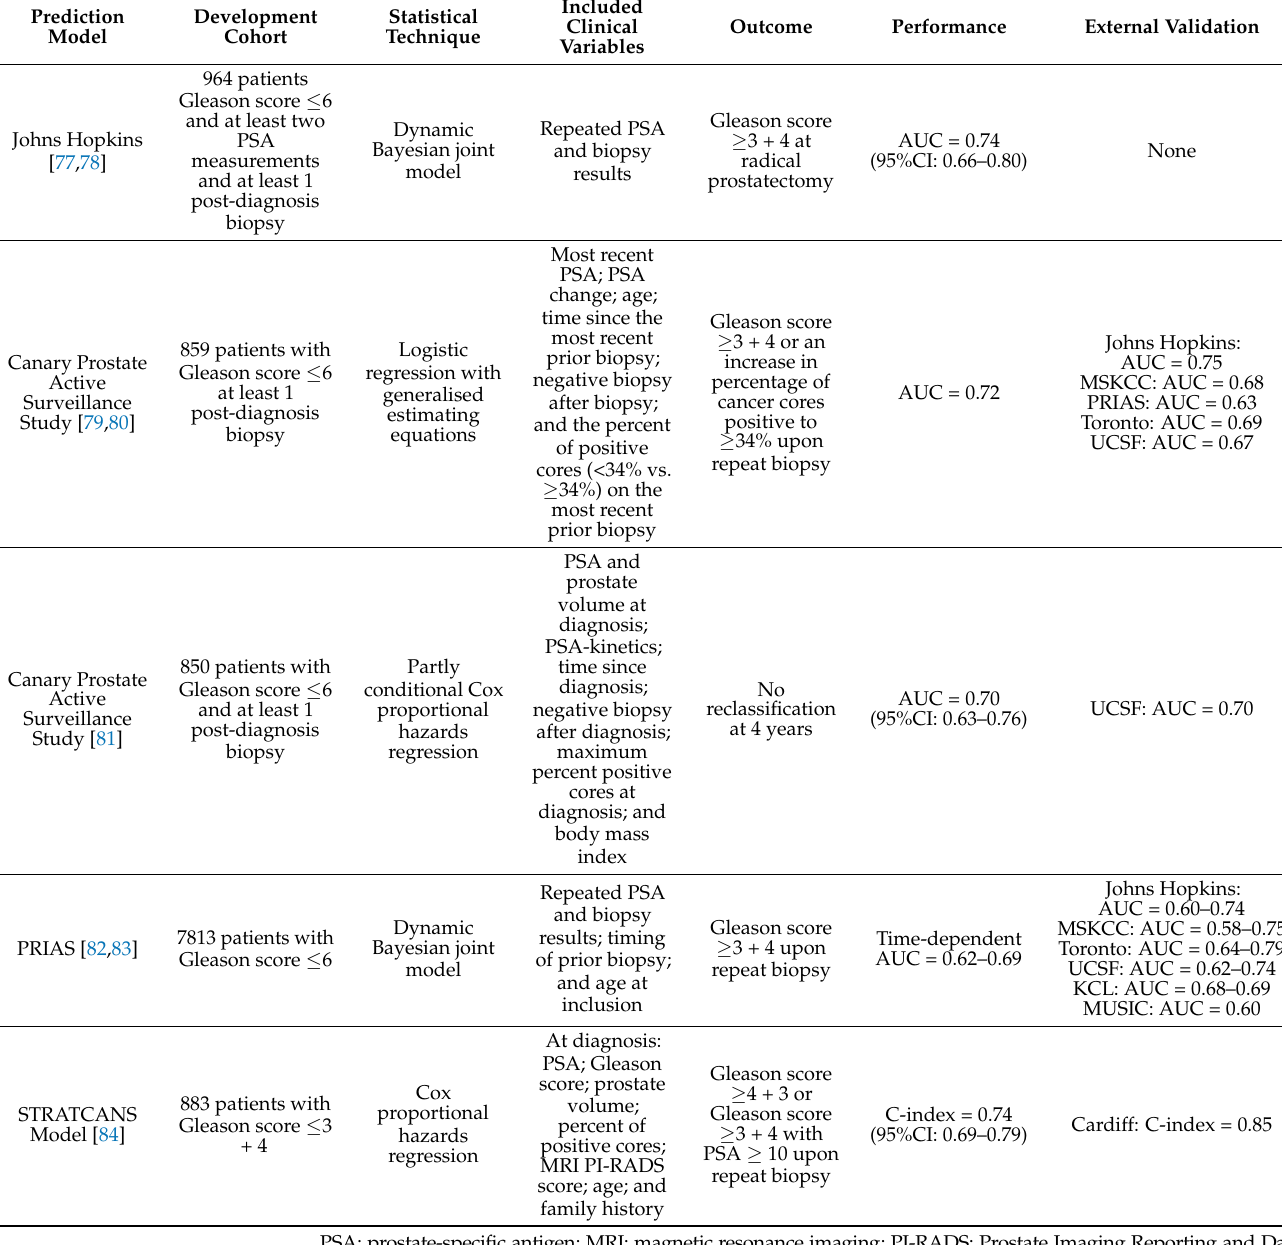
Table 3. Prediction models for reclassification in active